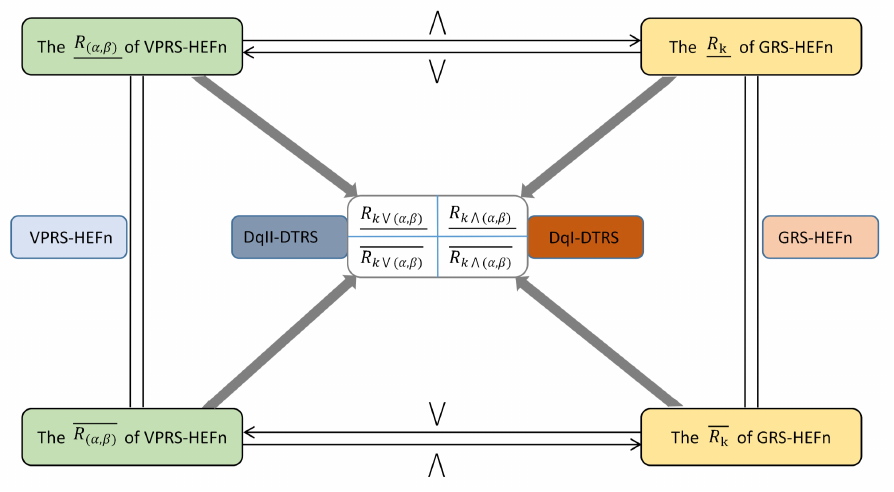
Figure 2. Formation of two double-quantitative